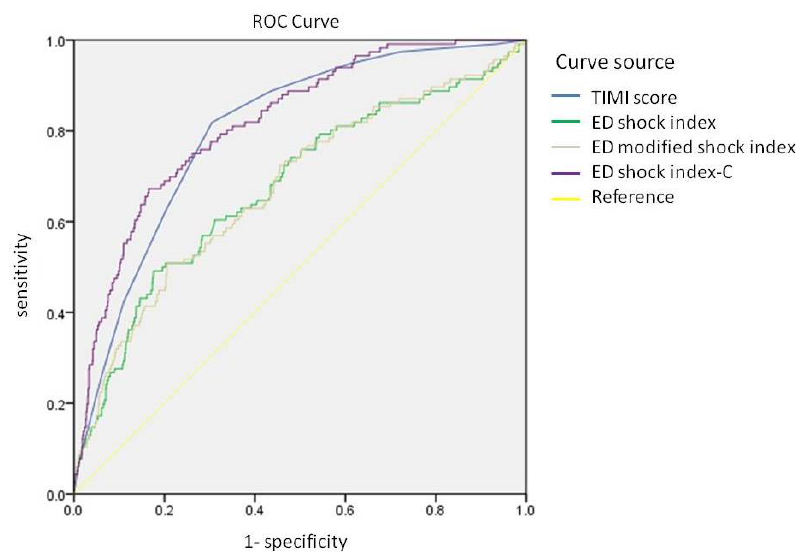
Figure 1. ROC curves of the ED shock index, ED modified shock index, ED shock index-C, and TIMI risk scores.